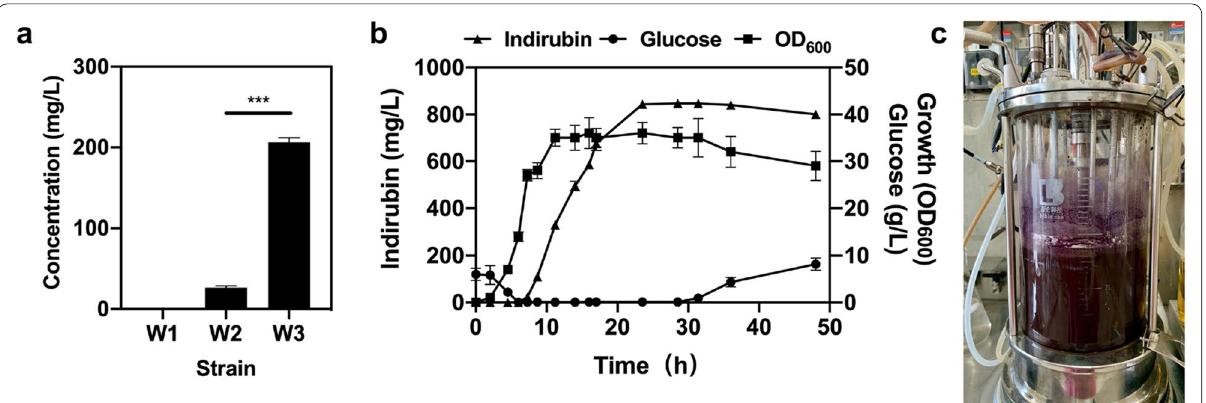
Fig. 9 a Titer of indirubin in vivo of various mutants. b Fed‑batch fermentation profiles of the engineered strain W3. Indirubin titer, cell growth and glucose concentration are shown. The data shown were chosen as a typical result from a series of experiments with consistent results. Error bar indicate standard error of the mean. c 5 L bioreactor used for fed‑batch fermentation of the W3